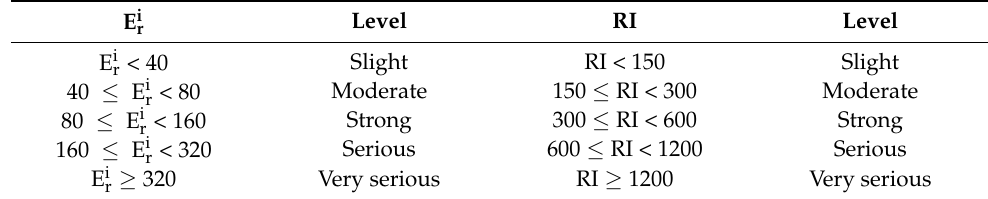
Table 4. The classification criterion of potential ecological risk index. E i r Level RI Level E i r < 40 Slight RI < 150